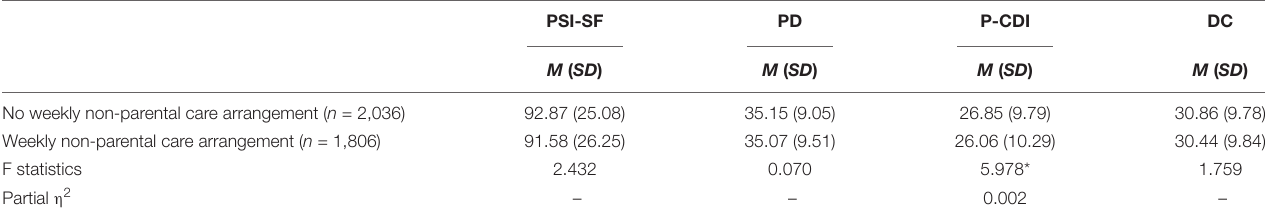
TABLE 3 | Comparisons of parenting stress between parents of children in and not in weekly non-parental care